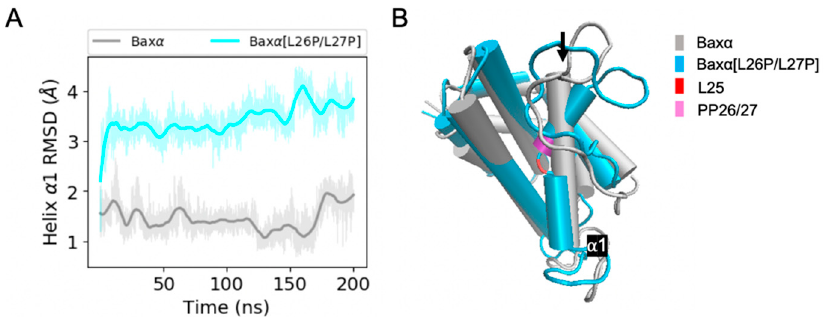
Figure 3. RMSD analysis of helix α 1. ( A ) RMSDs of Bax α and Bax α [L26P / L27P] helix α 1 backbone atoms in the core region relative to the initial structure for a period of 200 ns of MD simulations. ( B ) Representative structures of Bax α (grey) and Bax α [L26P / L27P] (blue). The black arrow points at helix α 1. Shaded lines show RMSDs for all recorded points and solid lines are smoothed as described in Section 4.4. Similar plots for two additional repetitions of the simulations are shown in the upper right panels of Figures S2 and S3.